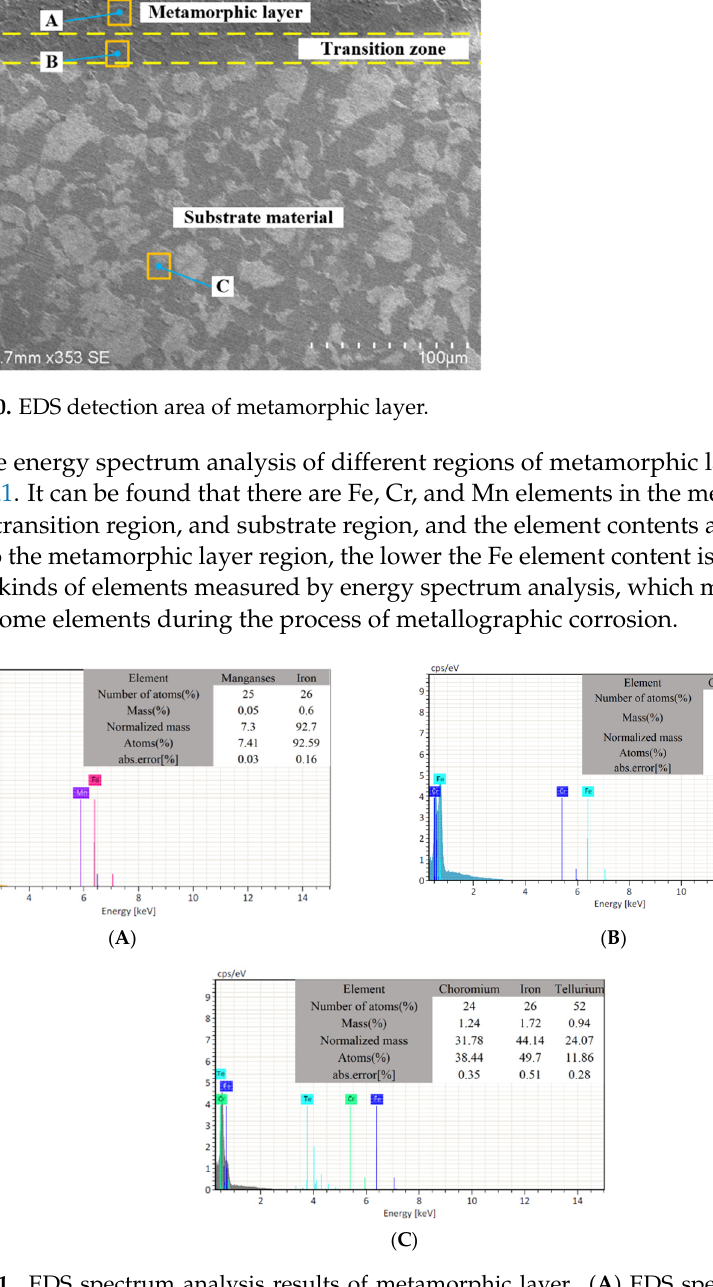
Figure 20. EDS detection area of metamorphic layer.